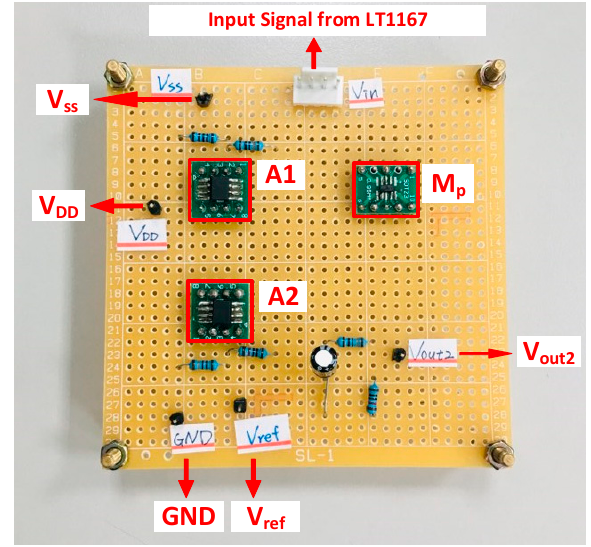
Figure 5. The implementation of the proposed calibration circuit.